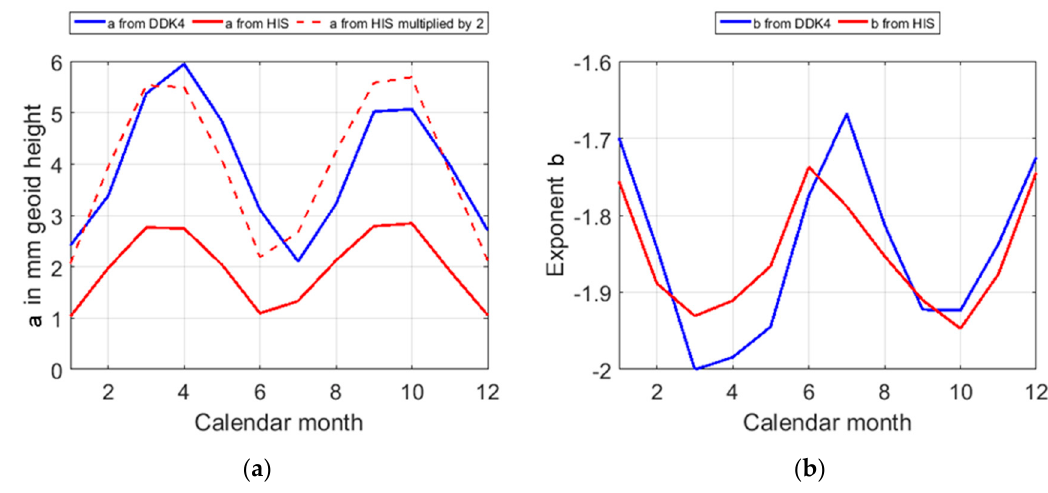
Figure 2. ( a , b ) coefficients for estimates of the Kaula rule signal variance from DDK4 filtered ITSG-Grace2014 solutions (blue) and HIS model data (red).